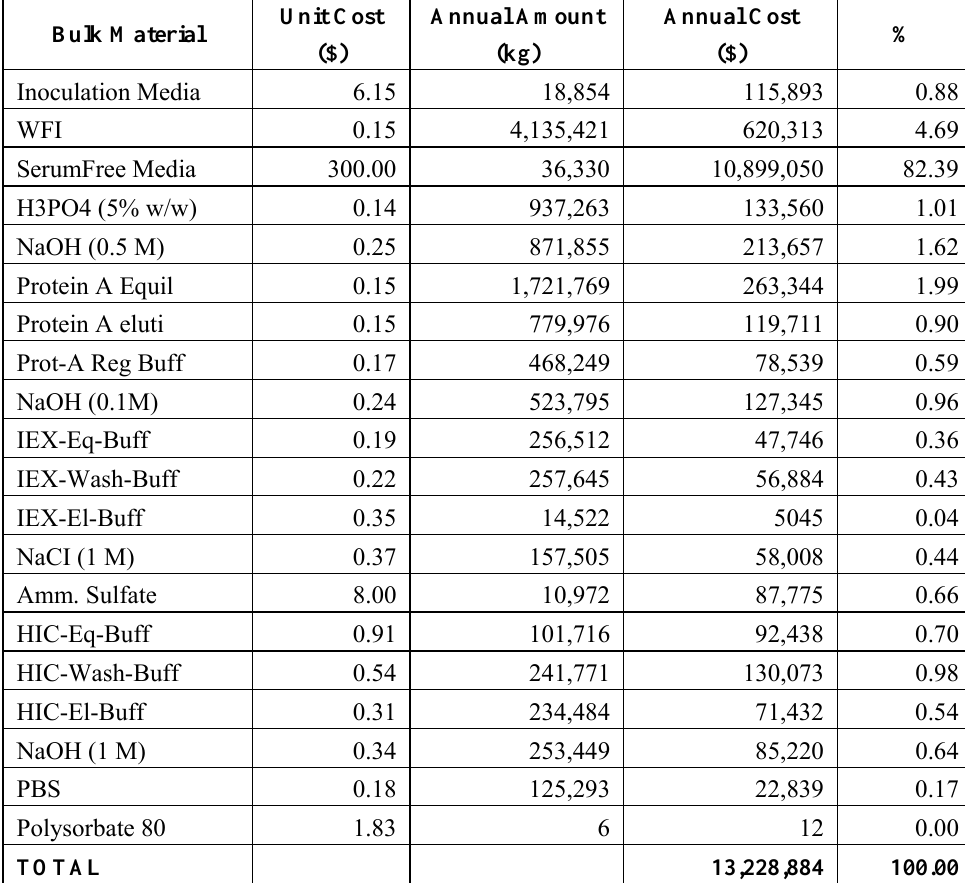
Table 6. Raw Materials Cost Breakdown (Year 2013 prices in US